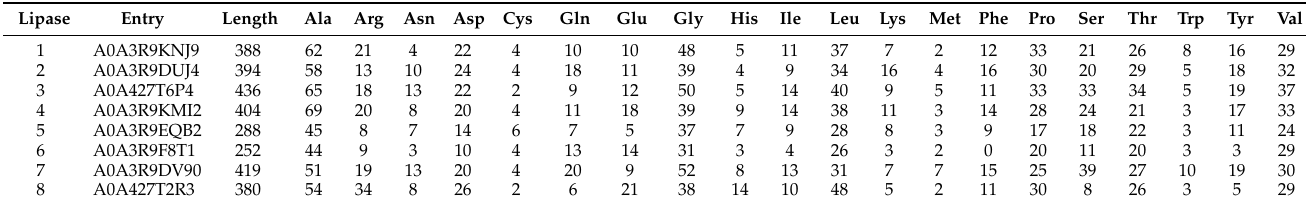
Table 4. Amino acid compositions of the Amycolatopsis eburnea lipases.